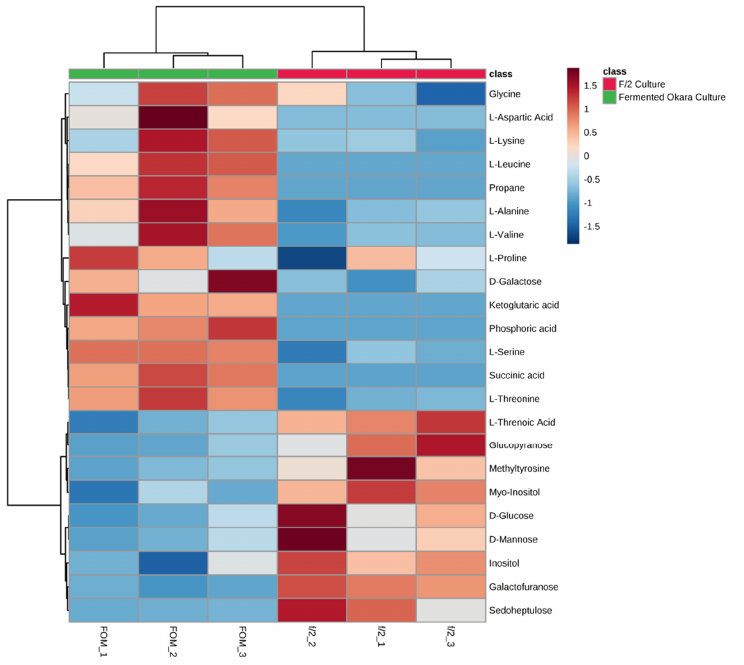
Figure 4. Heatmap analysis of the intracellular metabolites from F/2 culture and fermented okara culture.